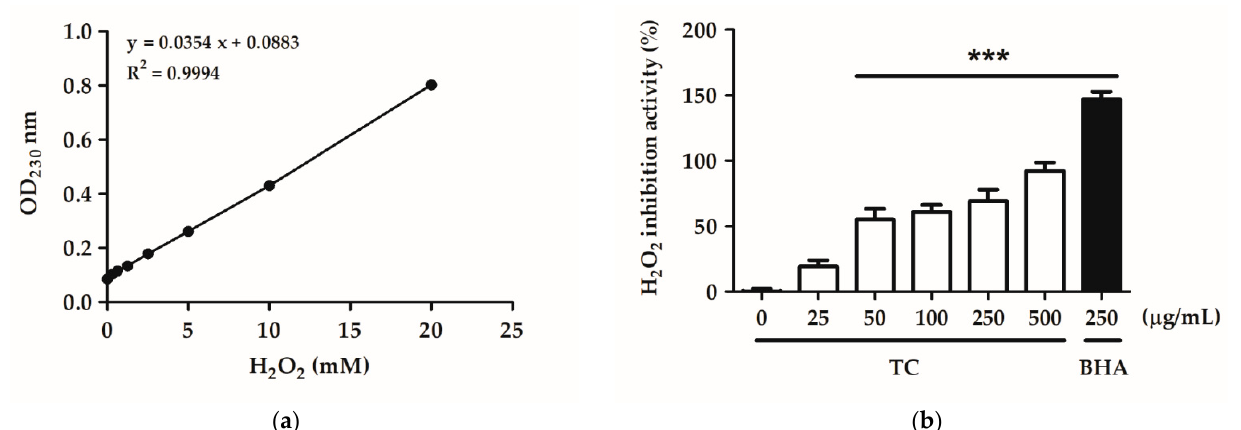
Figure 4. TC scavenges H 2 O 2 in a dose-dependent manner. ( a ) The standard curve of absorbance at 230 nm at different hydrogen peroxide concentrations. ( b ) The effect of TC on H 2 O 2 inhibition. TC showed a dose-dependent effect on H 2 O 2 inhibition, with an EC 50 value of 488.1 µg/mL and BHA as a positive control. Significant differences between treated groups and the negative control were evaluated. *** p < 0.001 compared to the control group.